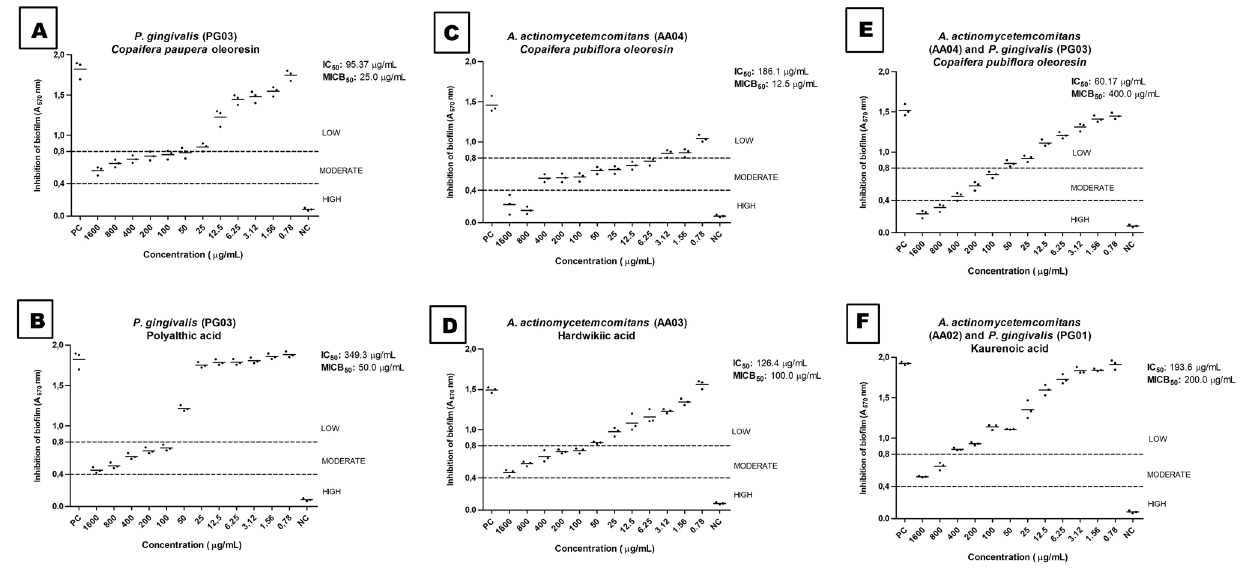
Figure 2. Biofilm inhibition of A. actinomycetemcomitans and P. gingivalis in the monospecies ( A , B , C , D ) and multispecies ( E , F ) modes.